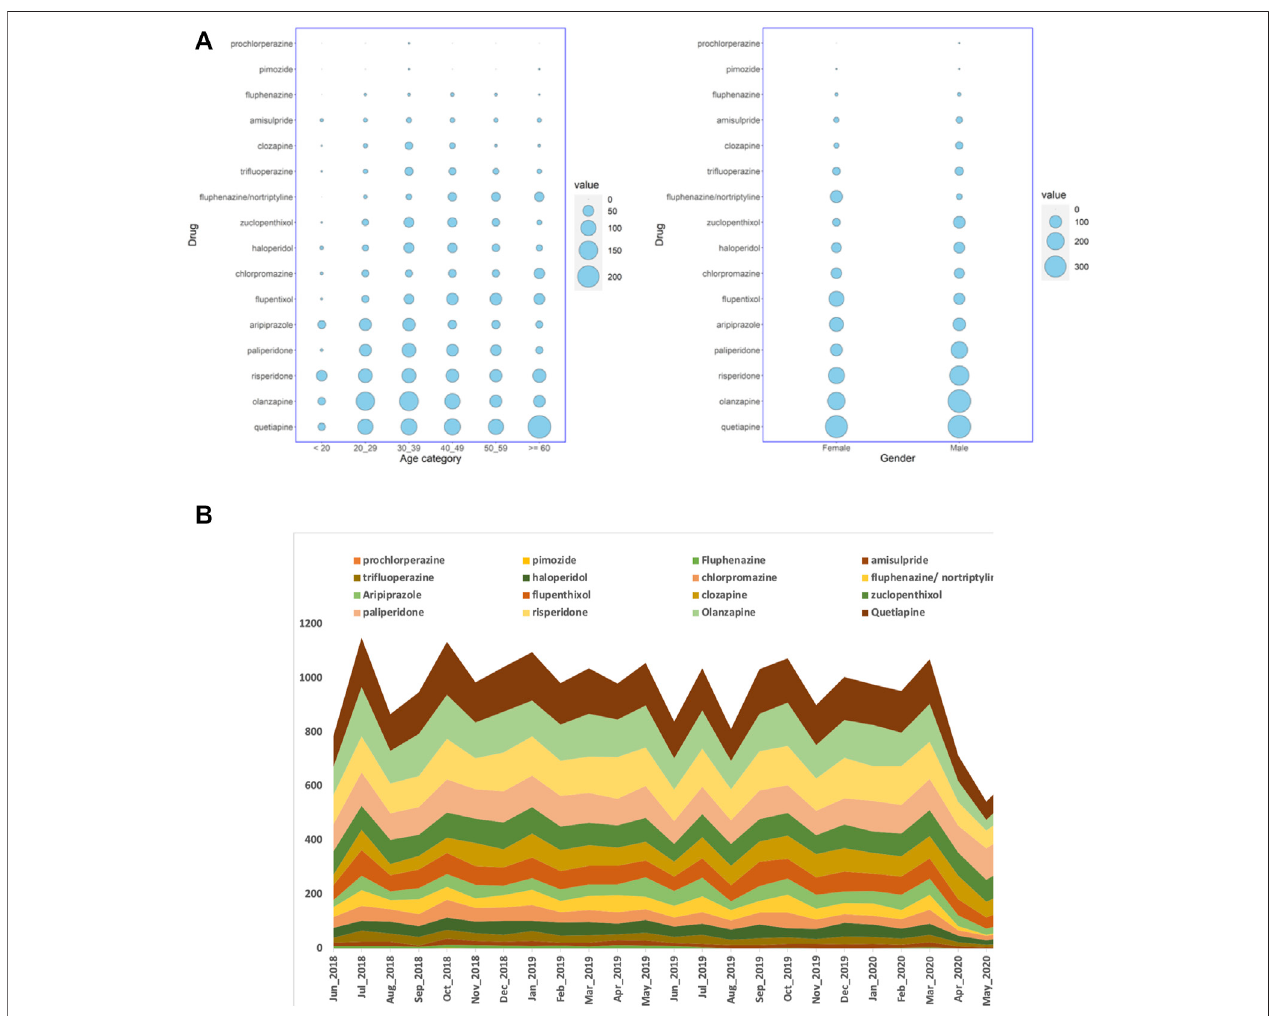
FIGURE 5 | (A) Balloon plots showing the distribution of the number of Qatari patients getting antipsychotic prescriptions over the study period of 24 months considering the Mental Health Hospital alone, and strati fi ed by age group or gender, and (B) the number of prescriptions of antipsychotics dispensed over a period of 24 months in the Mental Health Hospital alone. The cumulative number of monthly dispensed prescriptions on the Y-axis and the months are shown on the X-axis.